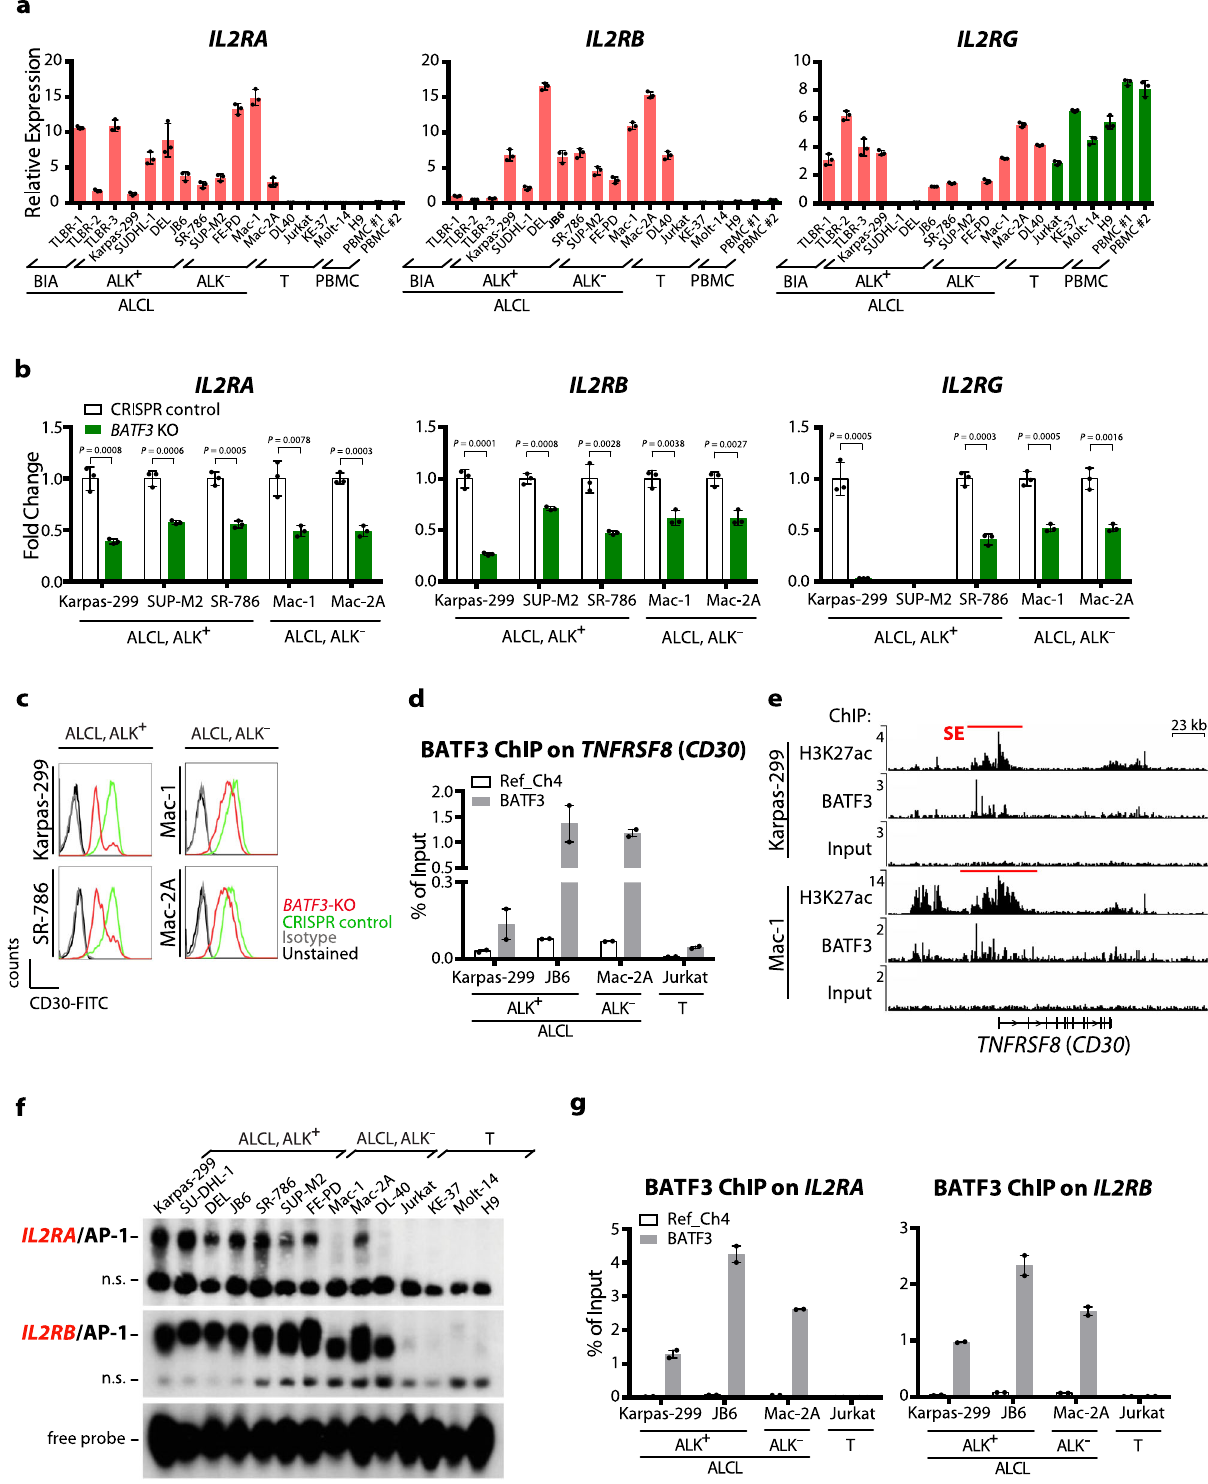
need for new treatment approaches for subgroups of ALCL, we explored IL-2R α as therapeutic target in ALCL. To this end, we used ADCT-301 (camidanlumab tesirine), a recently developed ADC composed of an IL-2R α -targeting monoclonal antibody coupled to a highly-potent pyrrolobenzodiazepine (PDB)-dimer cytotoxic warhead 39 . Cells were treated with ADCT-301 or the isotype control ADC B12-SG3249, recognizing HIV-gp120,